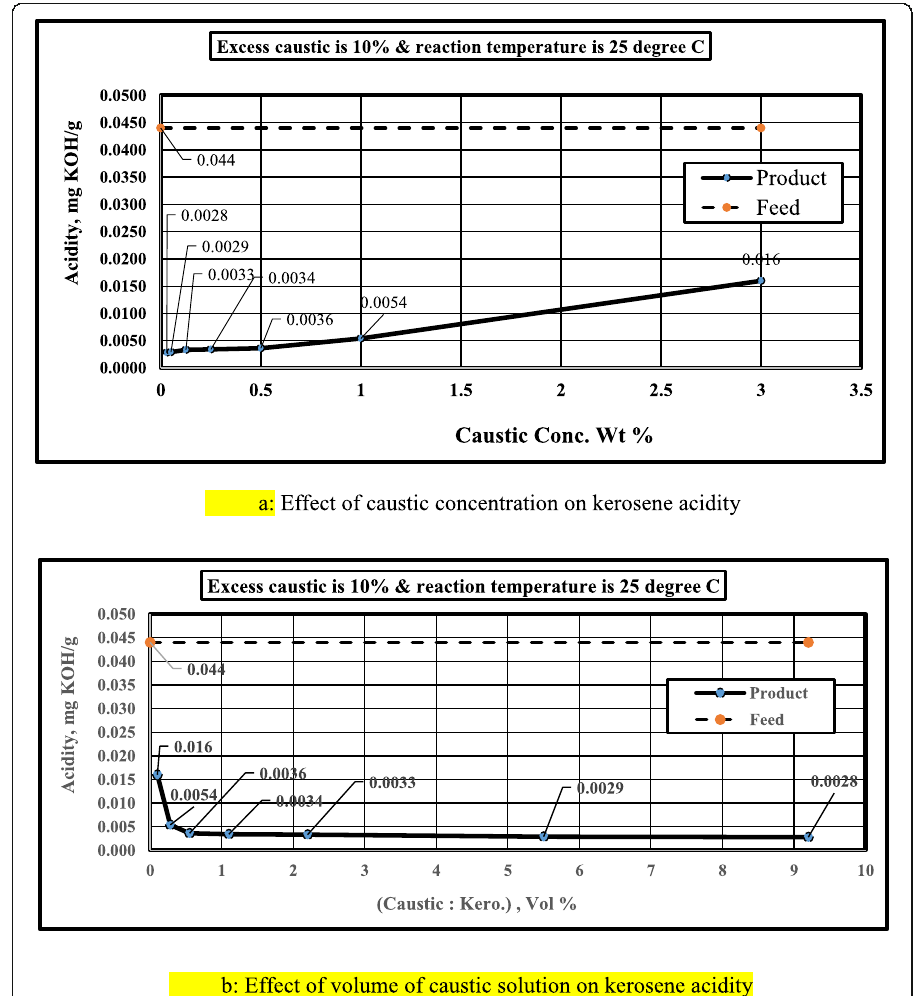
Fig. 2 a Effect of caustic concentration on kerosene acidity. b Effect of volume of caustic solution on kerosene